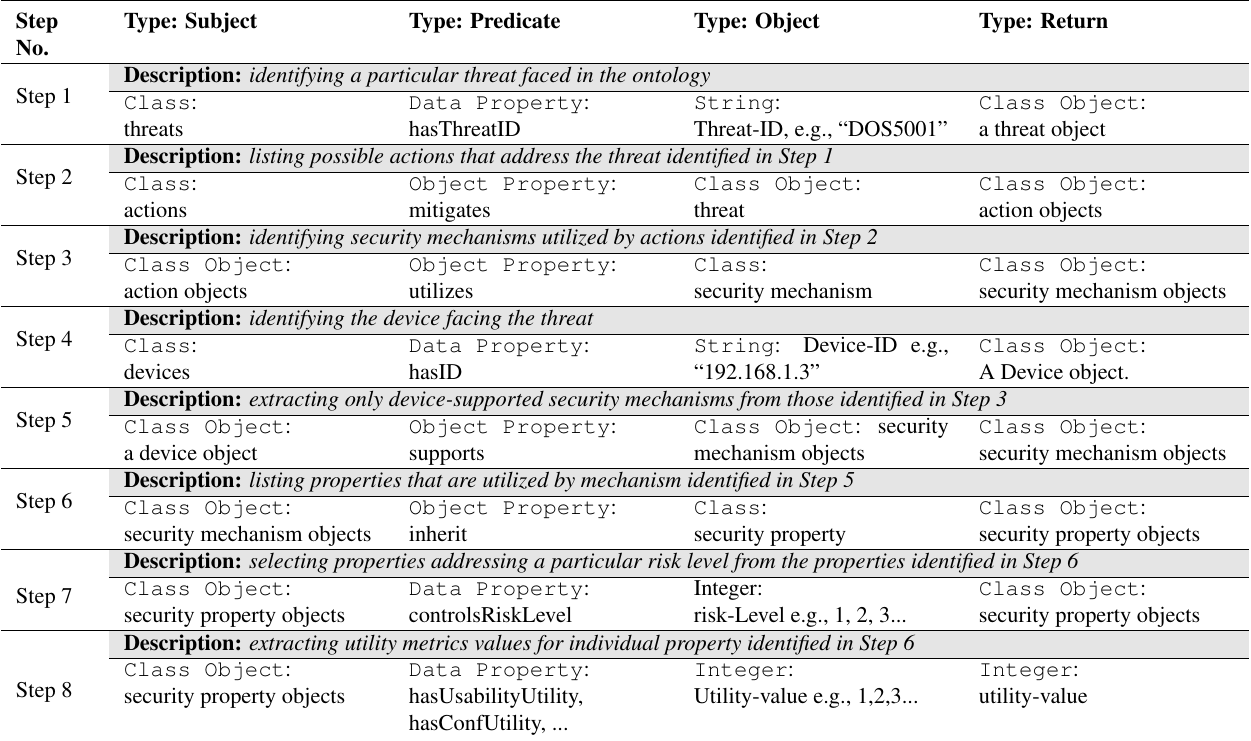
Table 1. The adaptation action decision process.